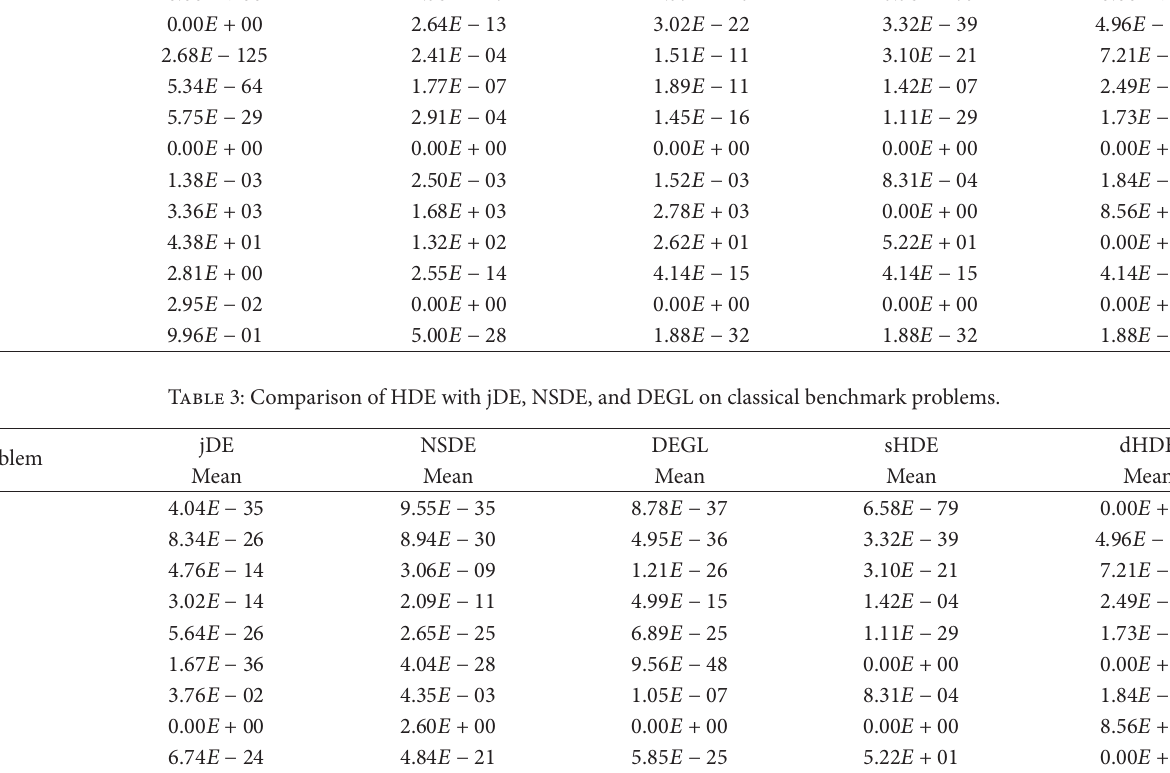
Table 2: Comparison of HDE with basic DE schemes on classical benchmark problems. Problem